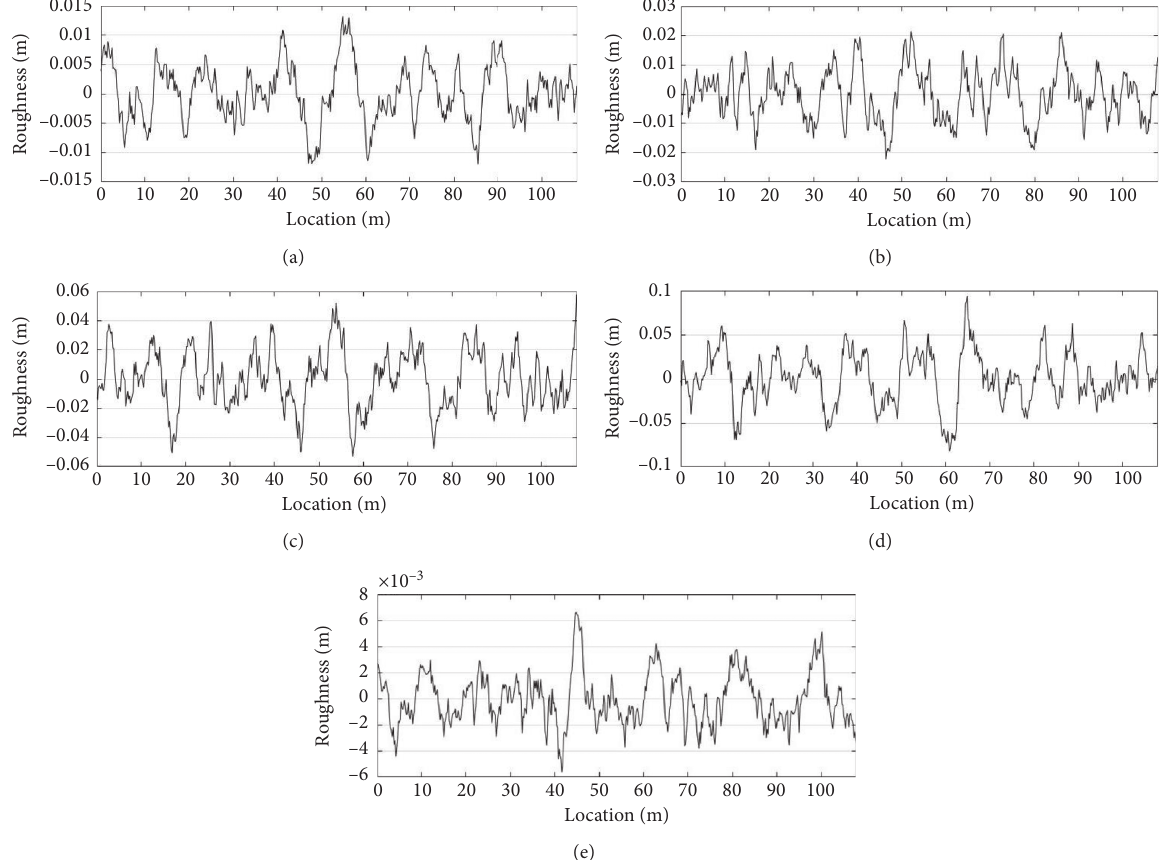
Figure 7: Pavement roughness: (a) very good ( α � 0.1 × 10 − 6 ); (b) good ( α � 0.5 × 10 − 6 ); (c) average ( α � 2 × 10 − 6 ); (d) poor ( α � 10 × 10 − 6 ); (e) very poor ( α � 20 × 10 − 6